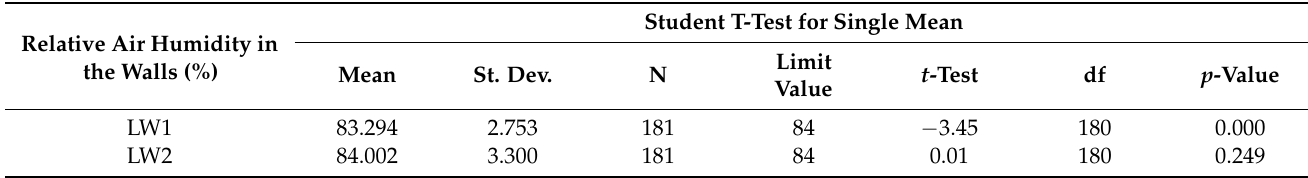
Table 8. Student T-test Results of Relative Air Humidity in the Walls in the HS21.